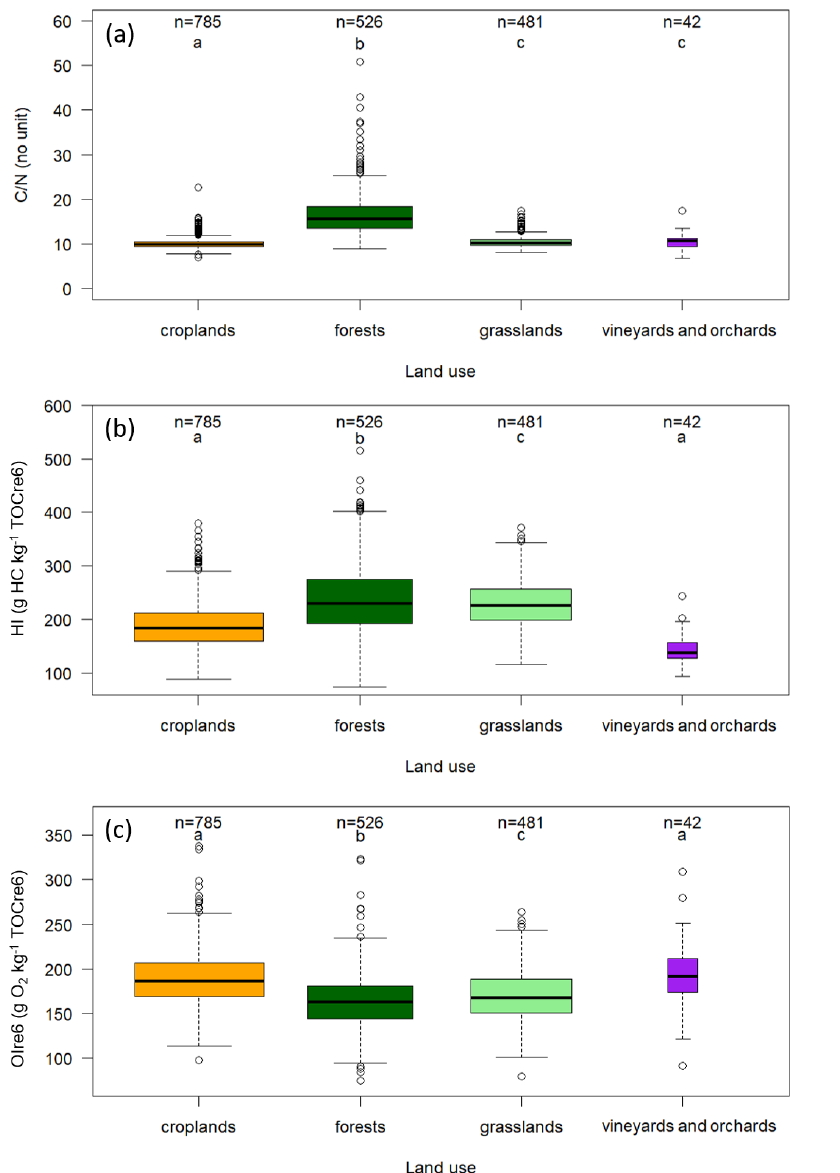
Figure A1. Effect of land cover on topsoil organic carbon stoichiometry for the RMQS topsoil (0–30cm) samples under the four major land covers in France: croplands, forests, grasslands, and vineyards and orchards. The individual panels show the (a) C / N distribution, (b) HI distribution, and (c) OIre6 distribution. Samples are limited to those with Rock-Eval ® organic carbon yields ranging from 0.7 to 1.3. For the box plots, the solid black midline of each box is the median, the lower and upper edges are the respective first ( Q 1 ) and third ( Q 3 ) quartiles, and the lower and upper whiskers are the maximum between the minimum value or the first quartile minus 1.5 times the interquartile range (max [min; Q 1 − 1 . 5 × ( Q 3 – Q 1 )]) and the minimum between the maximum or the third quartile plus 1.5 times the interquartile range (min [max; Q 3 + 1 . 5 × ( Q 3 – Q 1 )]), respectively. Different letters indicate significant differences in the distribution of the values for the land uses according to a Kruskal–Wallis test ( p< 0 . 05) and a pairwise Wilcoxon rank sum test ( p< 0 . 05). The box width is proportional to the square root of n